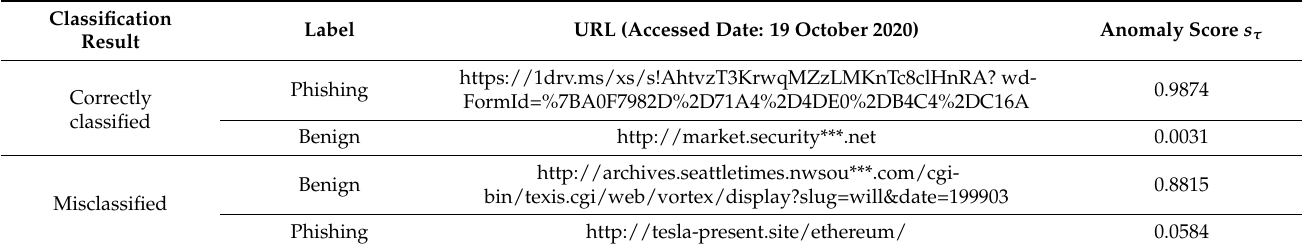
Figure 10. Decision boundary of URL representation extracted from the hidden layer of the proposed convolutional autoencoder. Table 6. Summary of the correctly and misclassified cases.